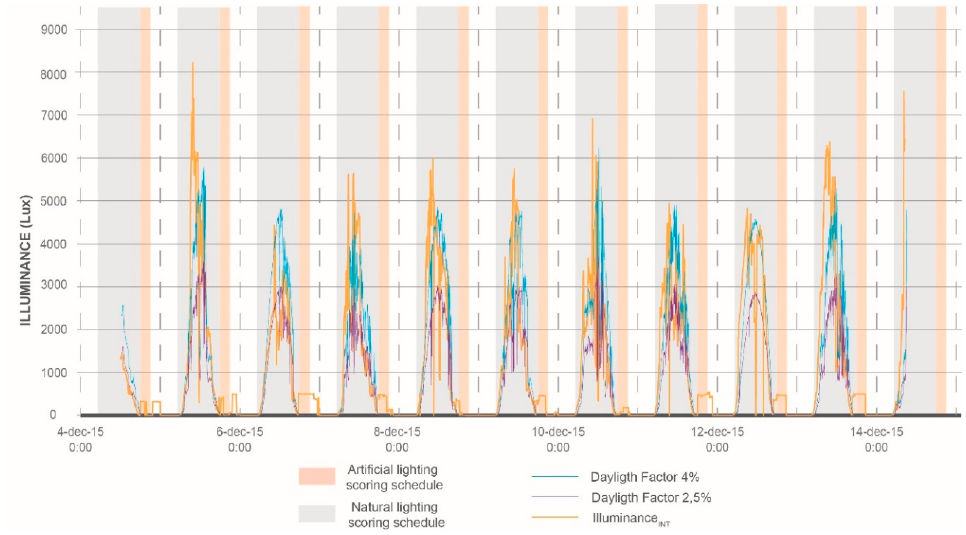
Figure 23. Graph of lighting behavior. Table 8. Nomenclature table with Table 7. Percentage of Hours (in scoring hours) in Lighting Range.